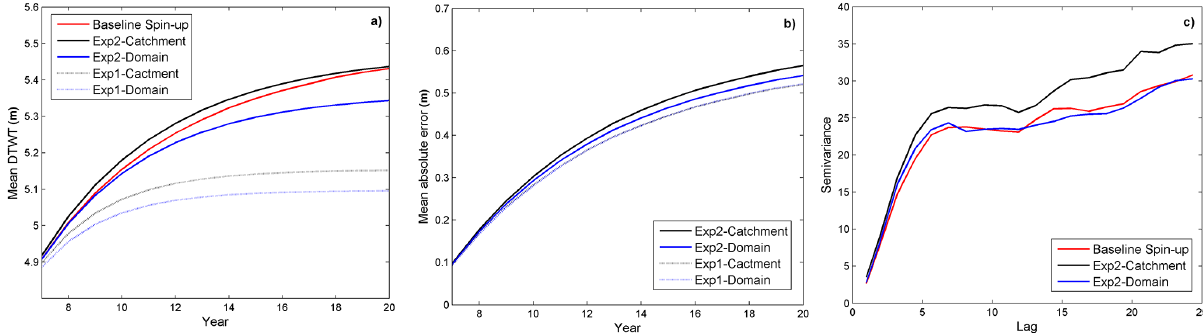
Figure 4. (a) Comparison between the simulated mean annual DTWT obtained from the baseline spin-up approach of ParFlow.CLM of the Skjern River sub-catchment and empirical DTWT functions. The single exponential model was formulated using the domain- and catchment- averaged data from spin-up simulations 2 to 6; (b) estimated mean absolute error based on simulated DTWT from the baseline spin-up together with both catchment- and domain-averaged single and double exponential functions; and (c) experimental semi-variograms of mean annual DTWT from the ParFlow.CLM equilibrium year (after 20years of simulations) and DTWT from catchment- and domain-averaged double exponential functions, showing that catchment-based semi-variances are higher than the baseline simulation. Exp1 and Exp2 refer to single and double exponential functions,